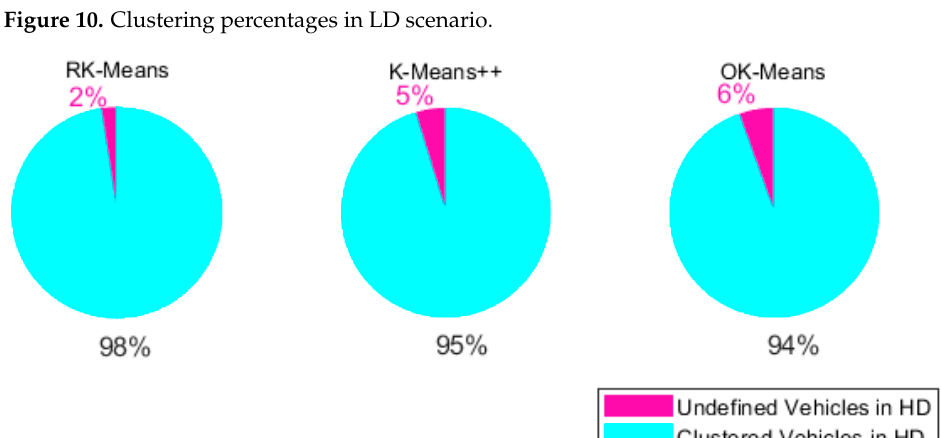
Figure 10. Clustering percentages in LD scenario.